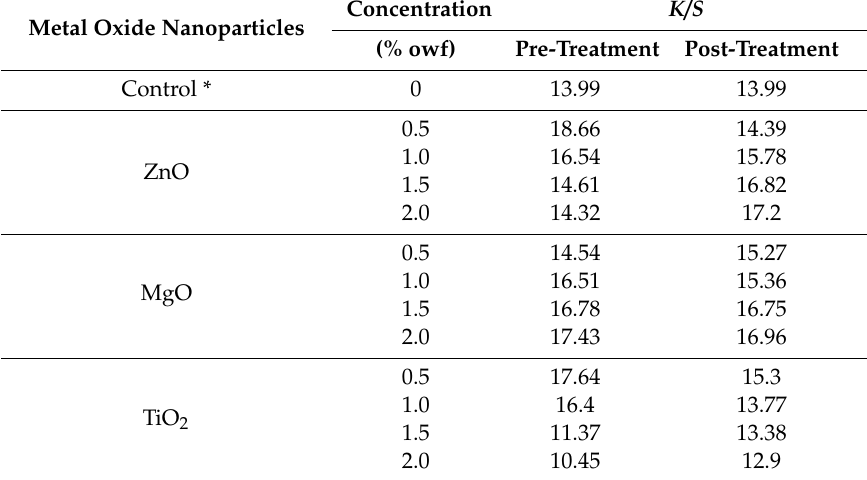
Table 4. E ff ect of pre- and post-treatment of acrylic fabrics with di ff erent metal oxide nanoparticles on color strength of printed fabrics using C.I. Basic Yellow 28 and carboxy lactic methacrylate (CLMA) thickener. Concentration K / S Metal Oxide Nanoparticles (% owf) Pre-Treatment